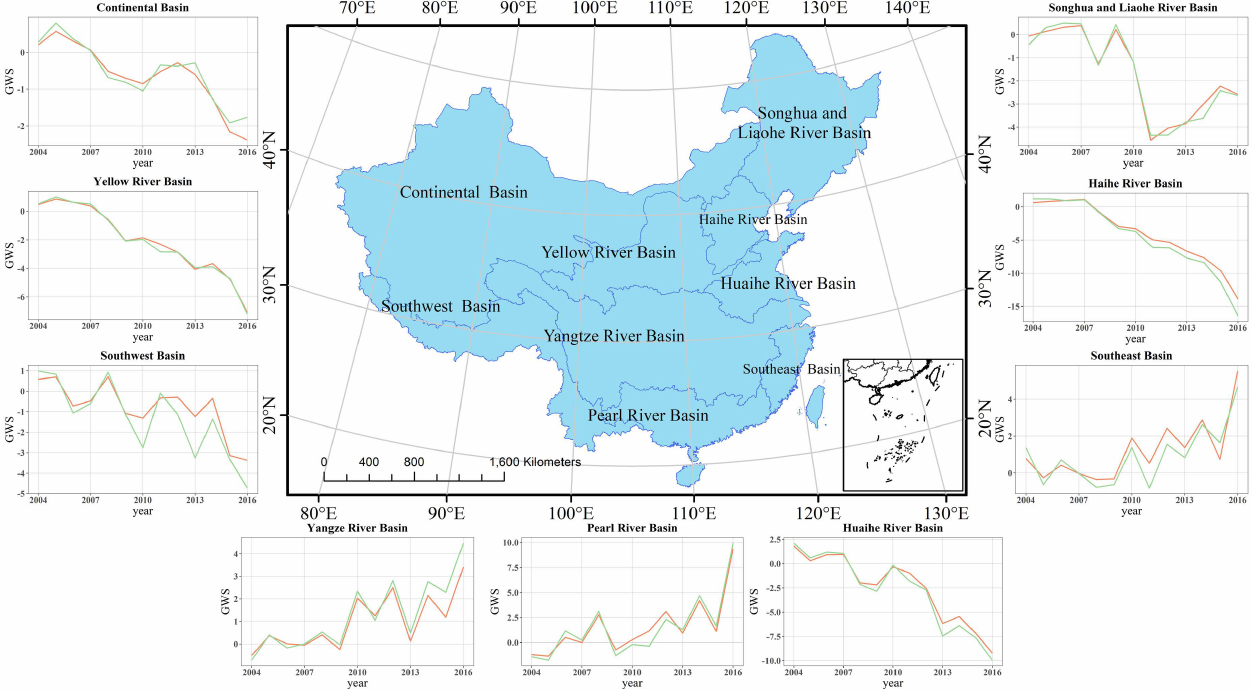
Figure 10. Annual GWS variations in 9 river basins for 2004–2016.